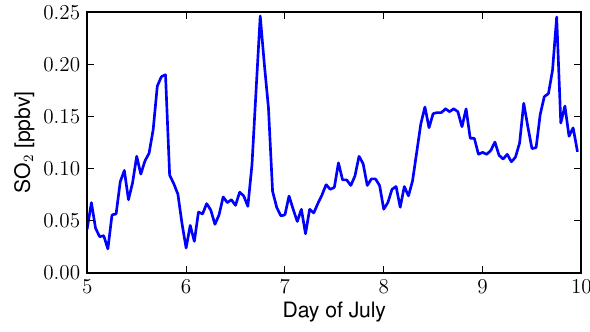
Fig. 6. Measured SO 2 mixing ratios at Raven’s